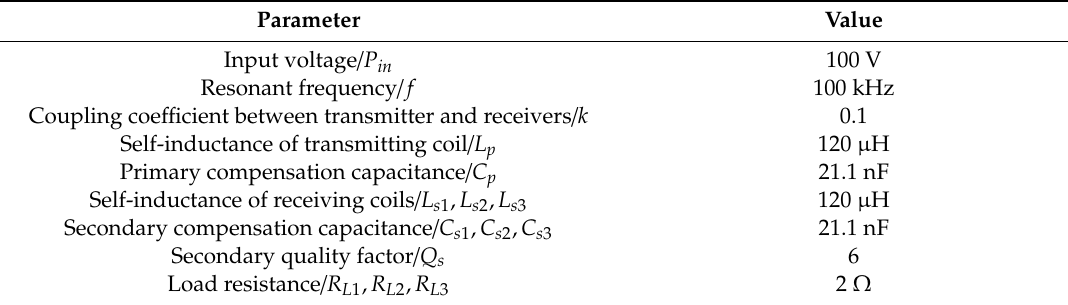
Table 1. Parameters involved in circuit model.